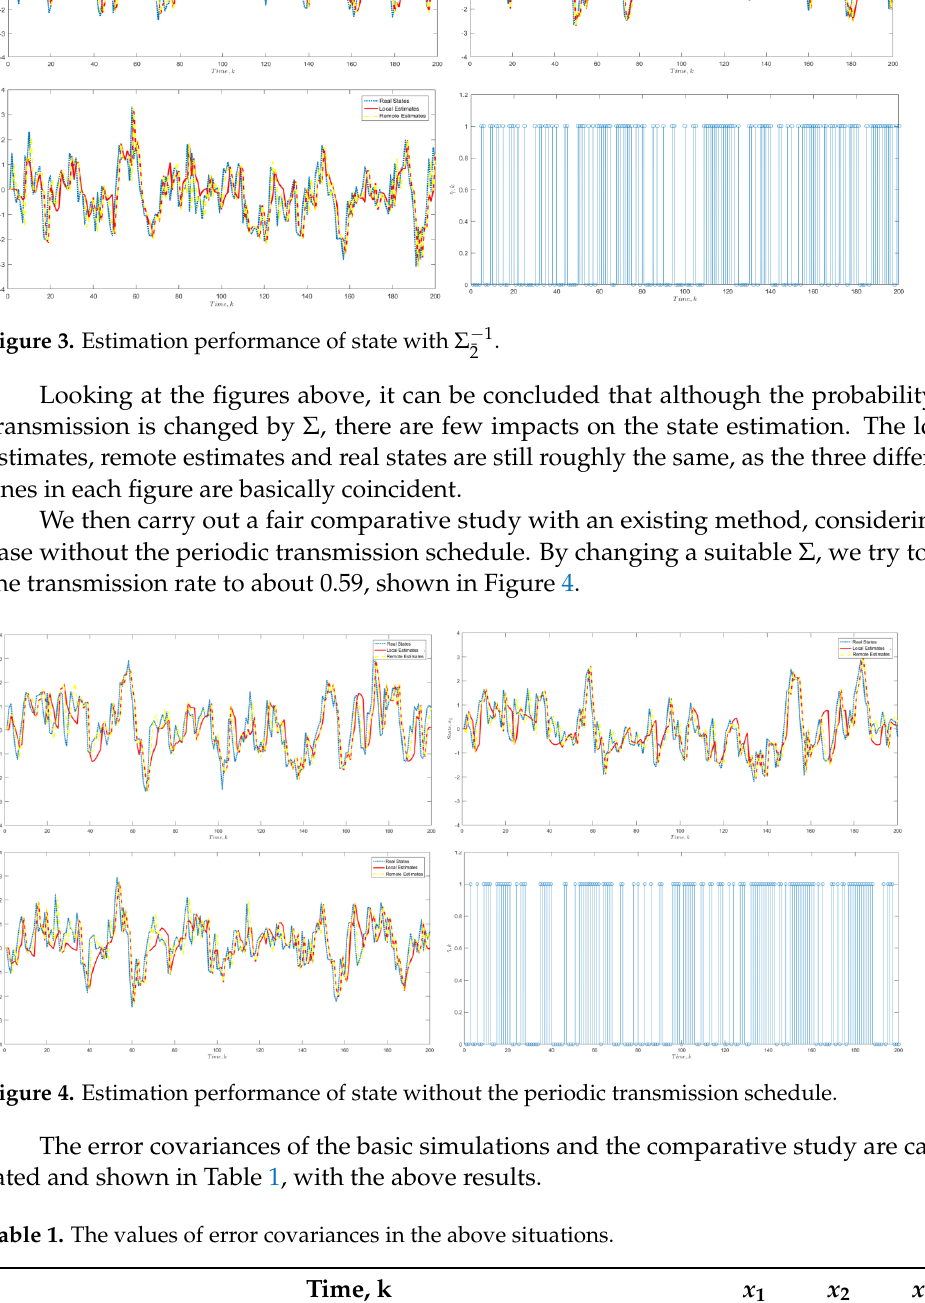
Figure 3. Estimation performance of state with Σ − 1